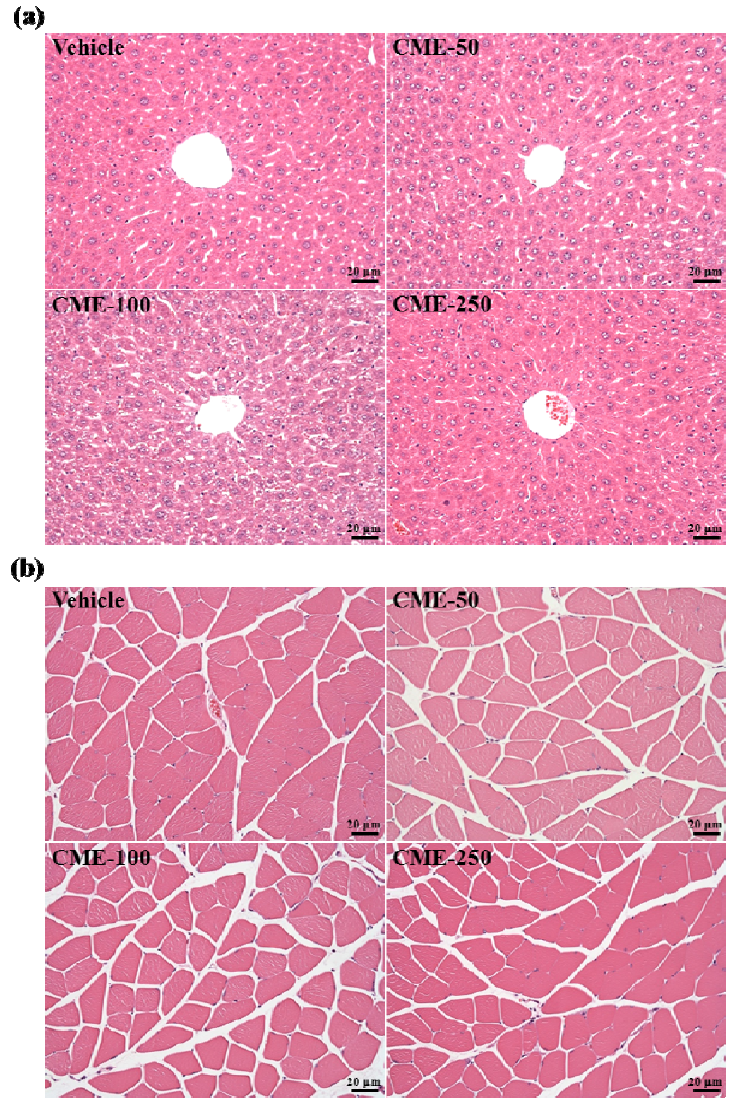
Figure 5. Effect of CME treatment on the morphology of liver ( a ) and skeletal muscle ( b ). Mice were pretreated with vehicle, 50, 100, and 250 mg/kg of CME for 14 days, all mice were sacrificed and examined for the morphology of liver and skeletal muscle at the end of experiment. Specimens were photographed with a light microscope (Olympus BX51; Olympus Co., Ltd., Tokyo, Japan). (H&E stain, magnification: ×200, Scale bar, 20 